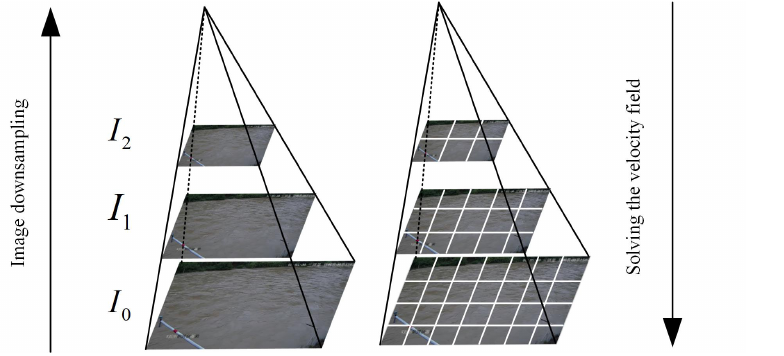
Figure 1. Image pyramid. Algorithm 1 Multiresolution Pyramid SGS-HS